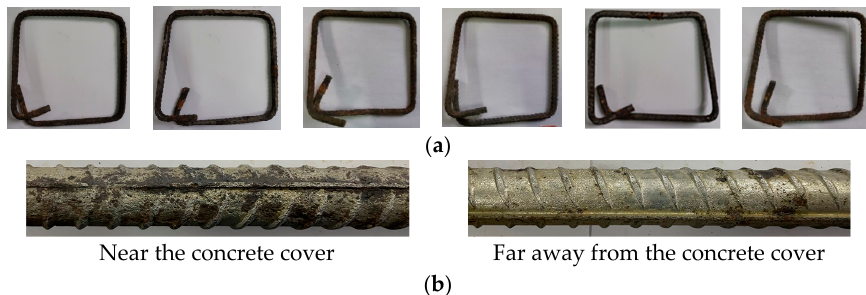
Figure 6. Detailed drawing of partial samples corroded inside the concrete. ( a ) Partial samples of corroded stirrups. ( b ) Partial samples of corroded main reinforcing steel bars. Table 2. Corrosion rates of reinforcing steel bars in columns.